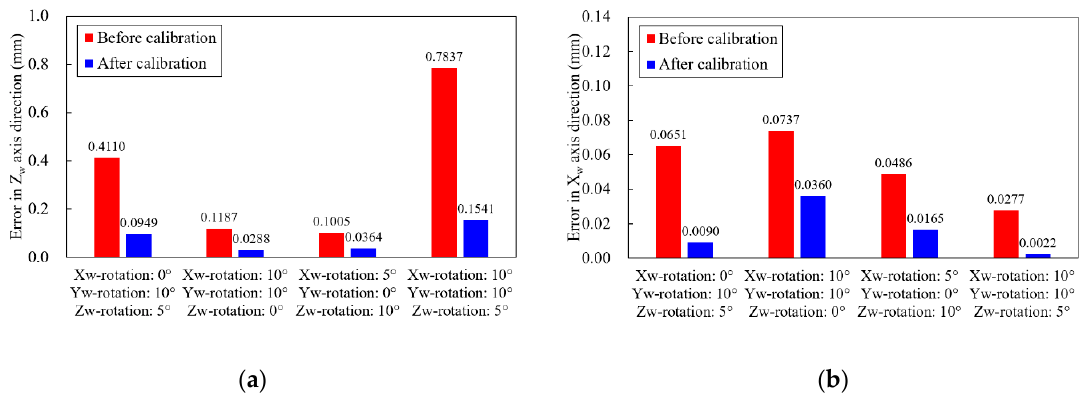
w and ( b ) Z w rotation errors.